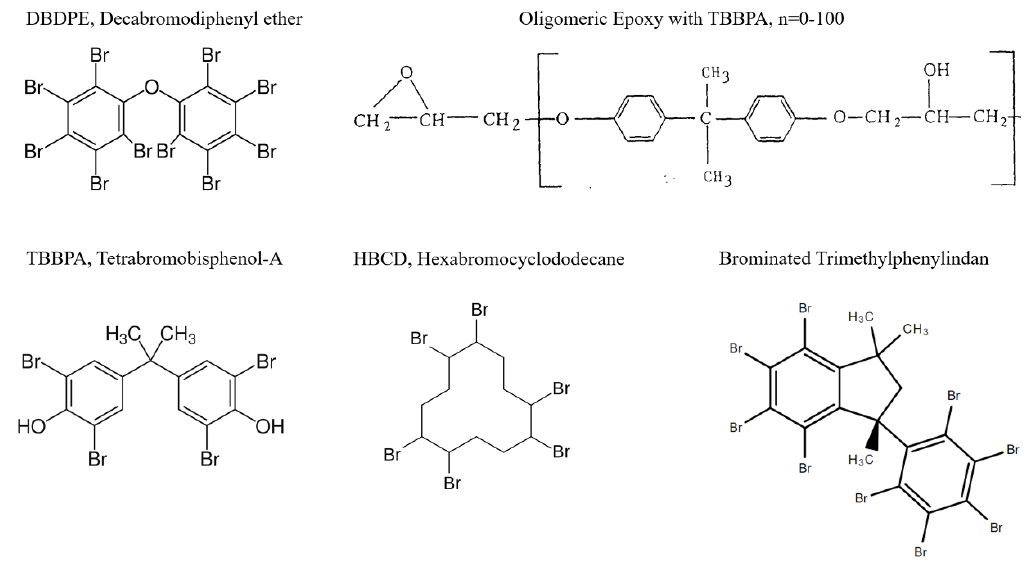
Figure 2. Brominated compounds contained in the Acrylonitrile Butadiene Styrene (ABS) samples.